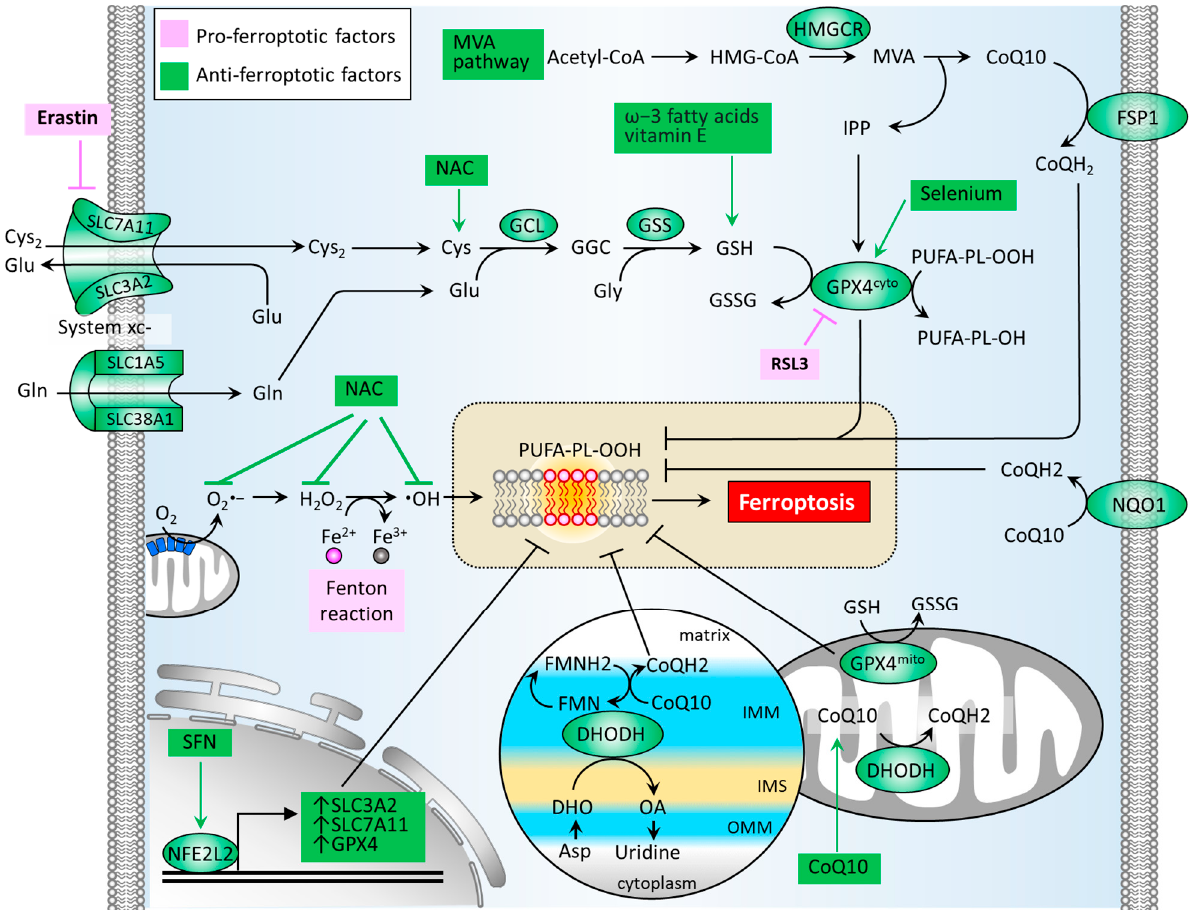
Figure 3. Molecular pathways of the antioxidant defense system that regulates ferroptosis. An antioxidant defense system is composed of GSH-dependent pathways (GSH/GPX4 and MVA) and GSH-independent pathways (FSP1/CoQ10 and DHODH/CoQ10). CoQ10, coenzyme Q10; CoQH2, reduced form of CoQ10; Cys, cysteine; Cys2, cystine; DHO, dihydroorotate; DHODH, dihydroorotate dehydrogenase; FMN, flavin mononucleotide; FMNH2, reduced form of FMN; FSP1, ferroptosis suppressor protein 1; GCL, glutamate-cysteine ligase; GPX4, glutathione peroxidase 4; GSH, glutathione; GSS, glutathione synthetase; GSSG, glutathione disulfide; HMGCR, HMG-CoA reductase; IMM, inner membrane of mitochondria; IMS, intermembrane space; IPP, isopentenyl-pyrophosphate; MVA, mevalonate; NAC, N-acetylcysteine; NFE2L2, nuclear factor, erythroid 2 like 2; NL-1, CISD1-targeting drug; NQO1, NAD(P)H quinone dehydrogenase 1; OA, orotate; OMM, outer membrane of mitochondria; ROS, reactive oxygen species; SFN, sulforaphane; SLC1A5, solute carrier family 1 member 5; SLC3A2, solute carrier family 3 member 2; SLC38A1, solute carrier family 38 member 1; SLC7A11, solute carrier family 7 member 11.